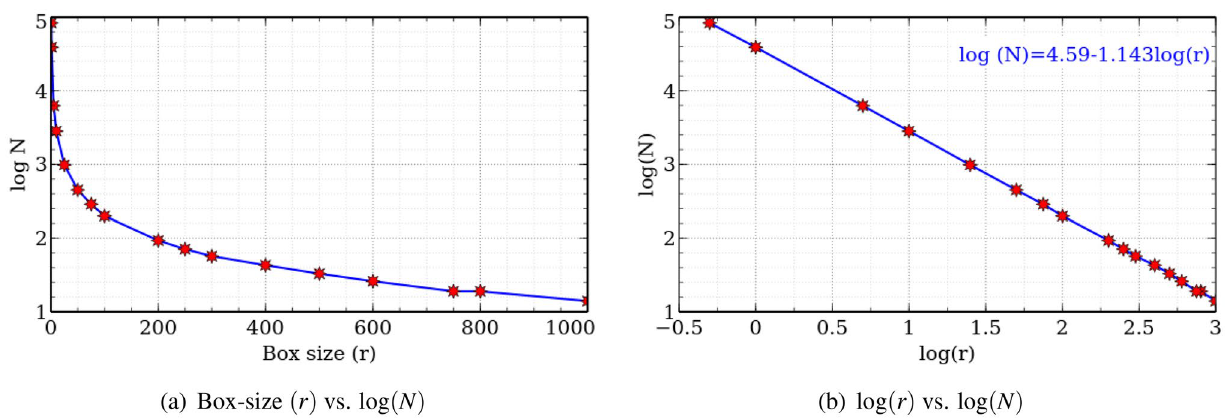
Figure 5. Plots for fractal dimension of coastline of Australia: box-counting method (created using Veusz software, version 3.2.1 available at https:// veusz. github. io/ downl